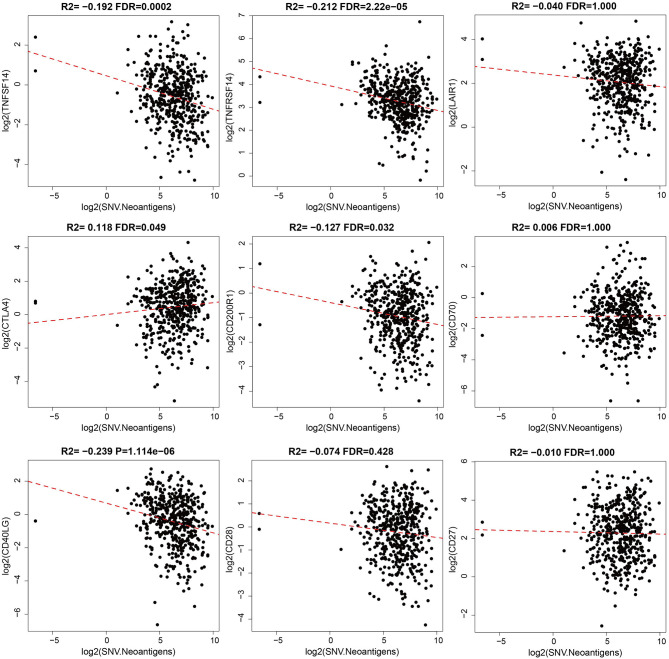
Correlation scatter diagram of IGCs' expression levels and neoantigens. R2 is the correlation coefficient, and FDR is false discovery rate. The abscissa represents log2 (neoantigens), and the ordinate represents genes.